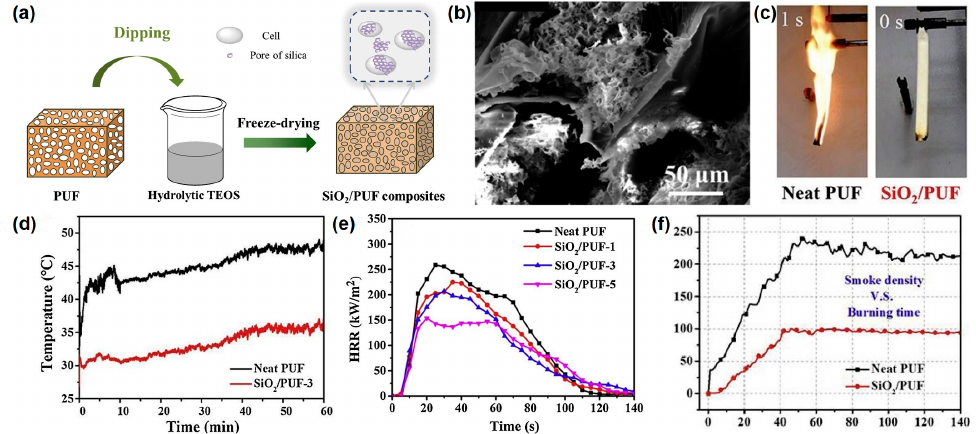
Figure 4. ( a ) Preparation route of SiO 2 /RPUF composites, ( b ) SEM image of SiO 2 /RPUF, ( c ) digital images of pure and SiO 2 aerogel-coated RPUF, ( d ) temperature vs. time curves of the upper surface points in thermal conductivity test, ( e ) HRR in cone test of pure PUF and SiO 2 aerogel-coated RPUF, and ( f ) specific density of neat and SiO 2 aerogel-coated RPUF in smoke chamber test [32]. Yan et al. [47] also reported a type of castor oil-based RPUF coated with silica aerogel by the sol-gel method of methyltrimethoxysilane (MTMS). In their work, the silica aerogel was successfully prepared by the sol-gel method of MTMS under the atmospheric drying process, as shown in Figure 5a. Two types of silica aerogel/SA/RPUF composites were prepared by adding SA during the foaming process of RPUF and by coating SA on the RPUF surface, respectively (Figure 5b). The RPUF with 0 wt% and 15 wt% SA powder were named as neat RPUF and RPUF-3. The dipped and dried neat RPUF and RPUF-3 were named as RPUF-4 and RPUF-5, respectively. From the cone test, the first and second p-HRR values of RPUF-4 were reduced by 52.43% and 40.78%, respectively, compared to the pure RPUF (Figure 5c). The first and second p-SPR were reduced by 56.86% and 47.82%, respectively. The RPUF-4 and RPUF-5 showed a remarkable decrease in the first and second p-SRP values compared to those of the neat RPUF and RPUF-3 (Figure 5d). The average CO production of RPUF-3, RPUF-4, and RPUF-5 decreased from 0.0029 kg/kg of pure RPUF to 2.3 g/kg, 1.5 g/kg, and 1.7 g/kg, respectively. (Figure 5e). The average CO 2 production of RPUF-3, RPUF-4, and RPUF-5 decreased from 0.27 kg/kg of pure RPUF to 0.25 kg/kg, 0.16 kg/kg, and 0.19 kg/kg, respectively (Figure 5f). From the above analysis, it can be seen that the formation of a silica aerogel layer on the surface of RPUF significantly improved the fire safety of RPUF and had a great application potential for improving the fire safety of the building insulation materials.